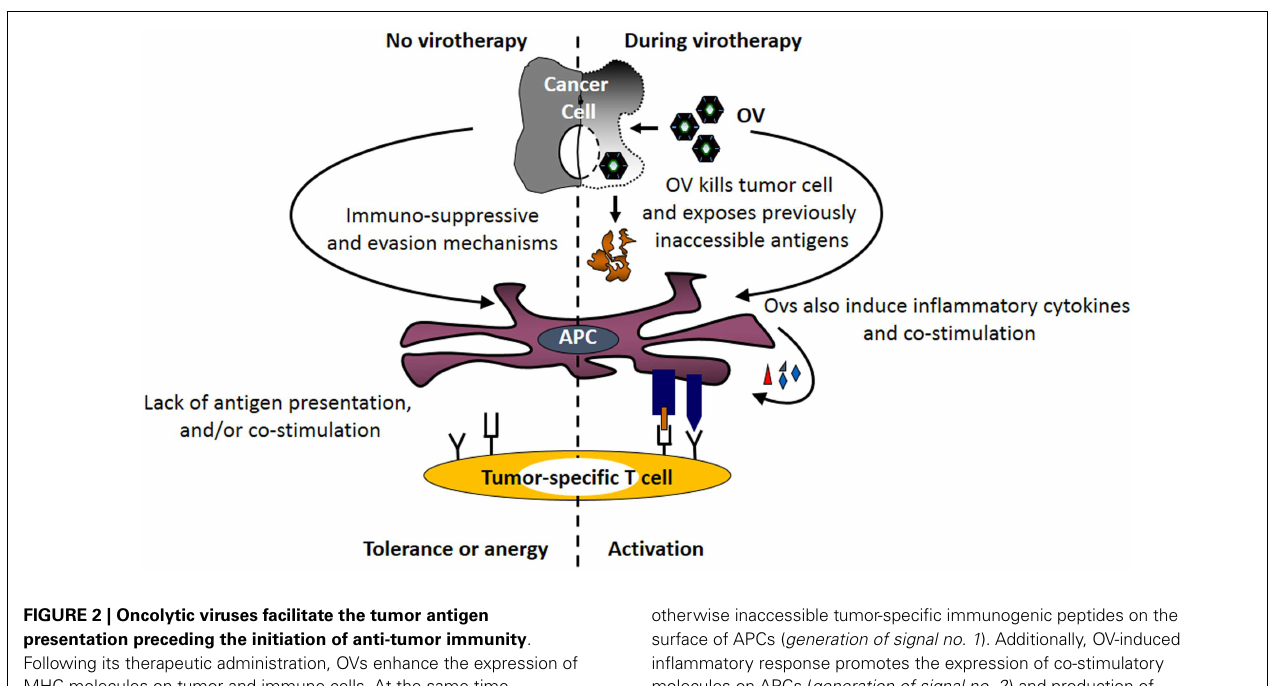
FIGURE 2 | Oncolytic viruses facilitate the tumor antigen presentation preceding the initiation of anti-tumor immunity . Following its therapeutic administration, OVs enhance the expression of MHC molecules on tumor and immune cells. At the same time, OV-mediated direct oncolysis of tumor cells exposes tumor-associated antigens (TAAs) for the processing by APCs.Through the combined actions of these immunological events, OVs facilitate the display of